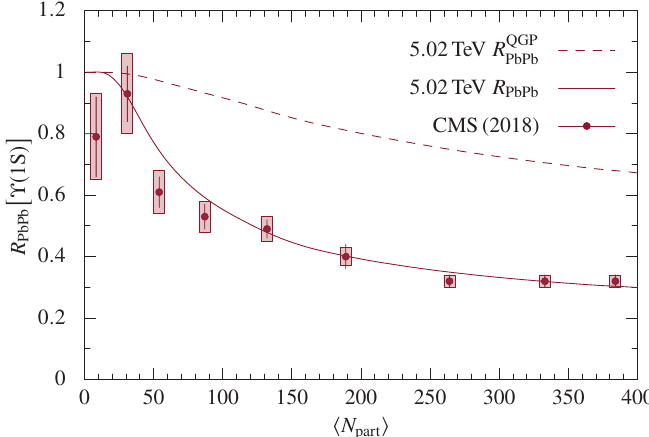
Figure 12. Centrality-dependent suppression factor R AA ( Υ ( 1 S )) in Pb-Pb collisions at √ s NN = 5.02 TeV (solid line, from Reference[3]) together with data from CMS (dots, | y | < 2.4, Reference[74]), as function of the number of participants N part (averaged over centrality bins). The suppression in the QGP-phase is the dashed curve, the solid curve includes reduced